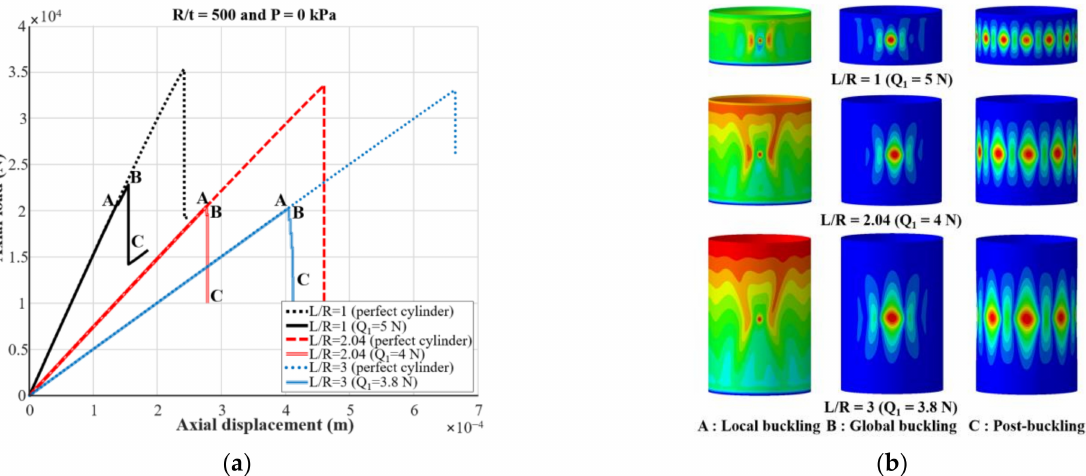
Figure 8. Post-buckling analyses results under axial compression for the cylinders R / t = 500. ( a ) Load-displacement curves, ( b ) Buckling